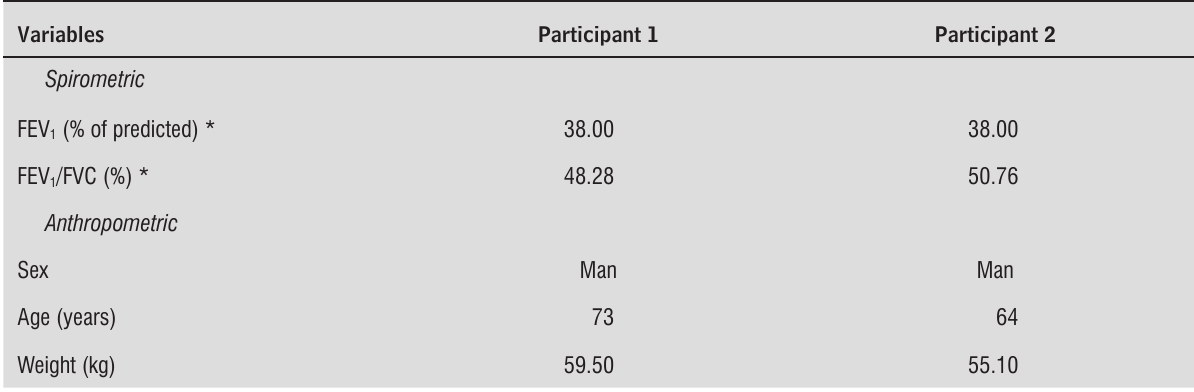
Table 1 - Spirometric and anthropometric data for the two